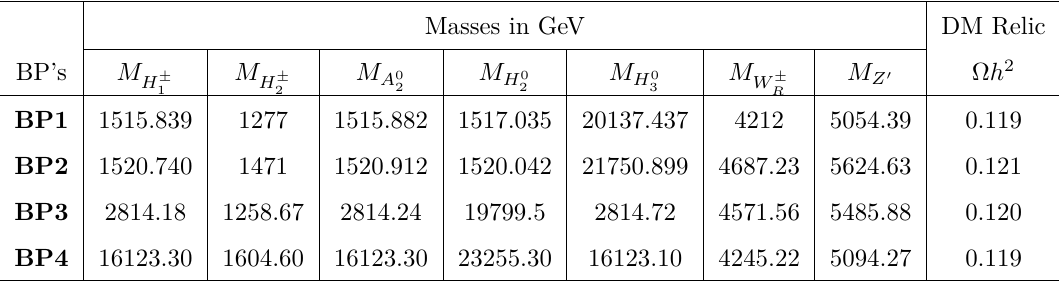
Table 7 . Masses of the gauge bosons and heavy scalars corresponding to the four Benchmark Points considered in this study.